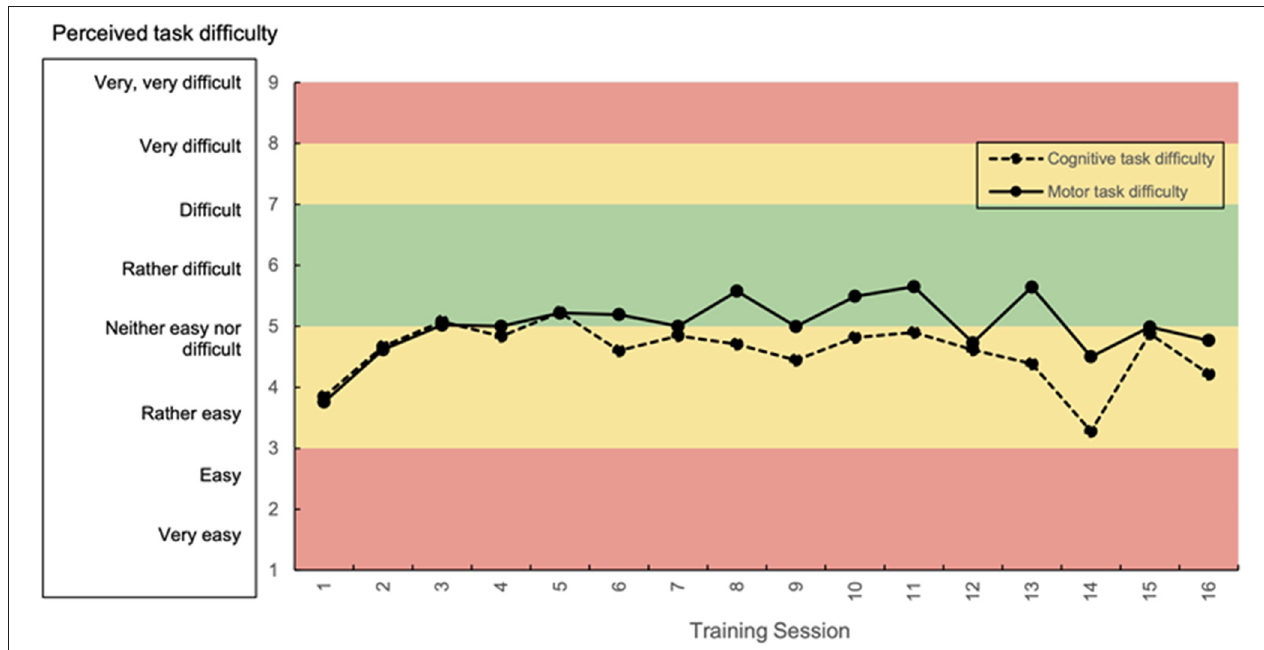
FIGURE 6 | Mean ratings for perceived motor and cognitive task difficulty over all participants. Green area: targeted range of perceived task difficulty.